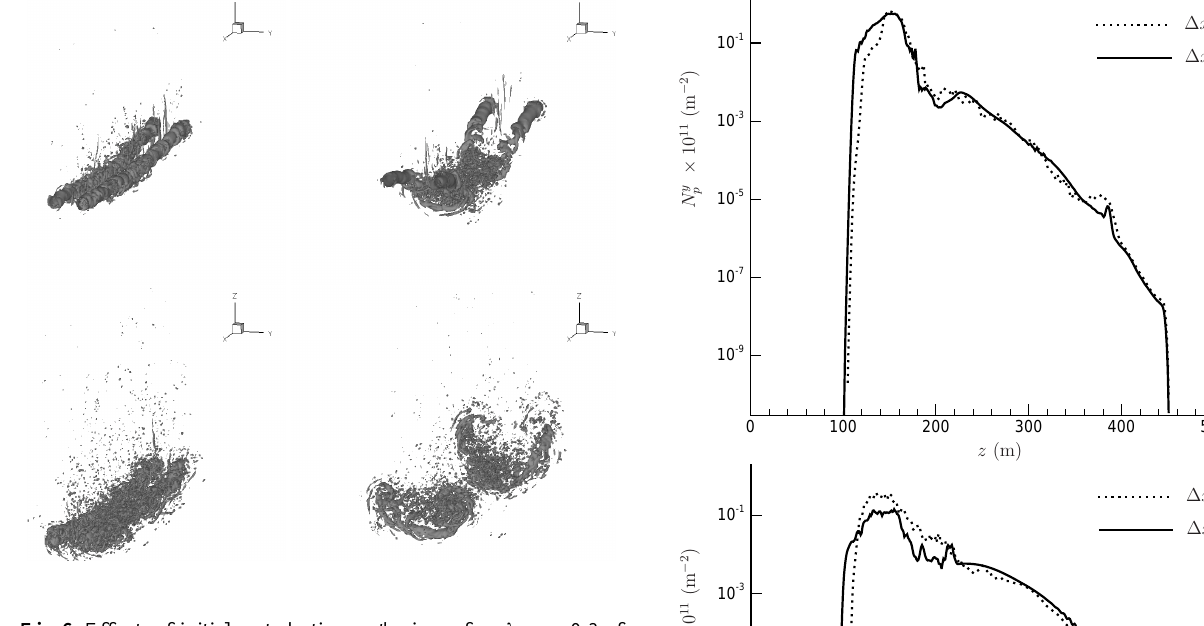
Fig. 6. Effects of initial perturbation on the isosurface λ 2 =− 0 . 3 of the vorticity invariant at t = 120s (top) and t = 140s (bottom). Left: = 0 . 02 (run V 1); right: w 0 = 0 . 15 (run V 2). w 0 LW LW